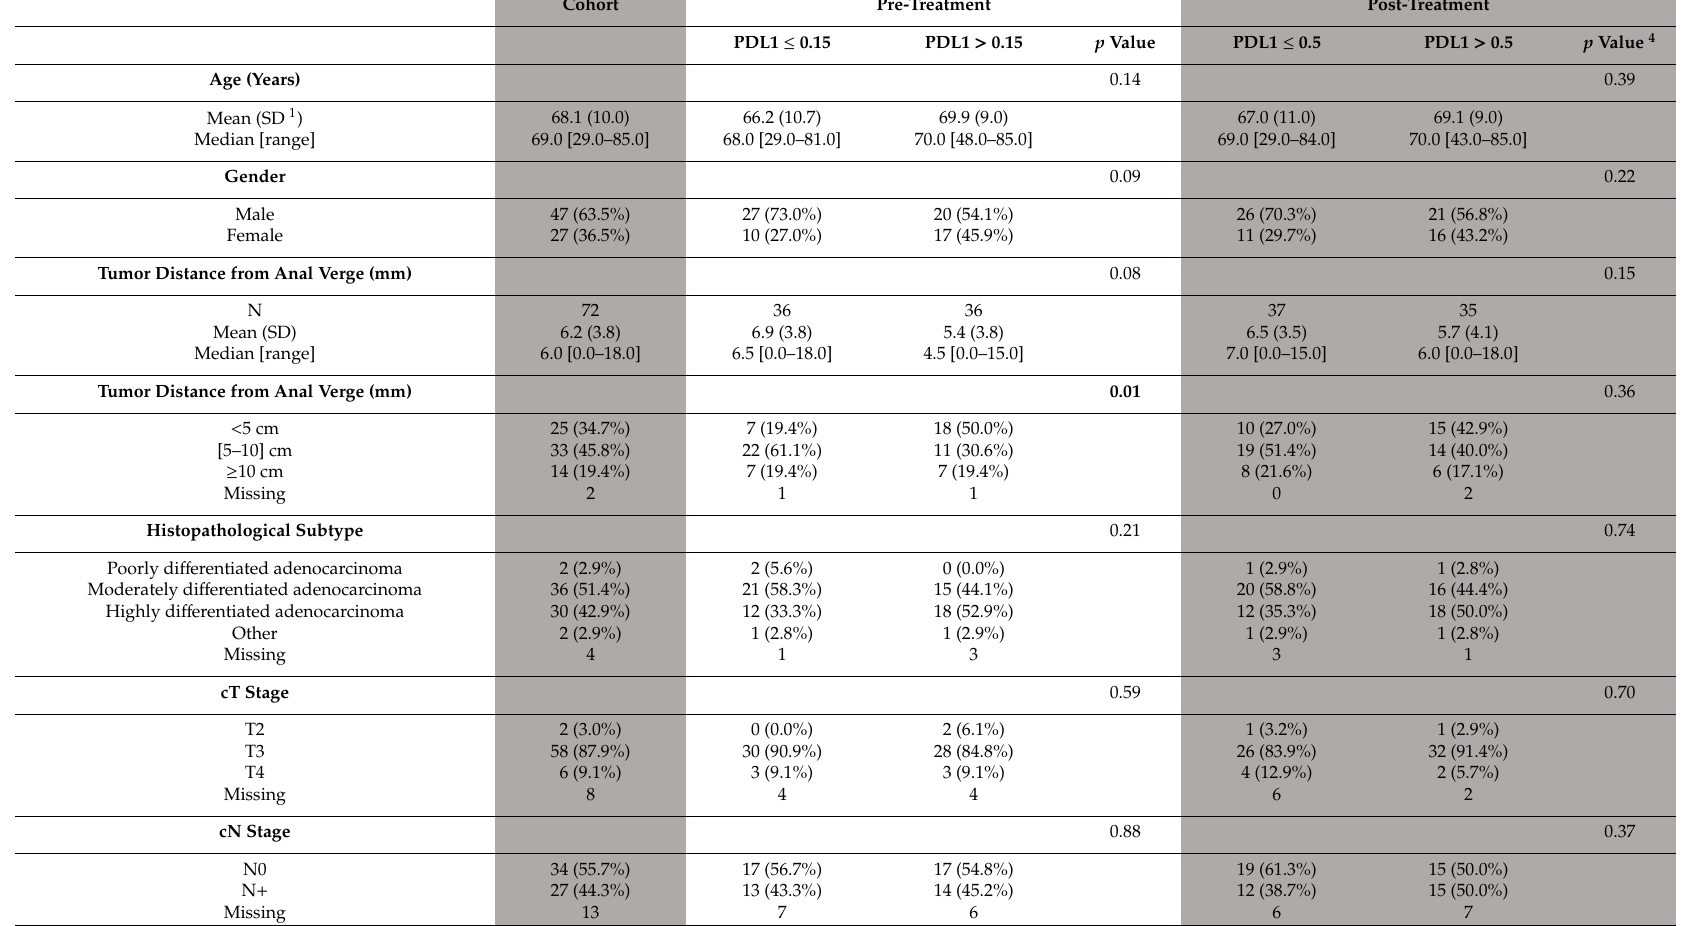
Table 1. Patients, tumor, and treatment characteristics for the entire cohort (Column Cohort). Characteristics were compared according to the median PD-L1 + cells rate on biopsy (column pre-treatment) and surgical specimen (column